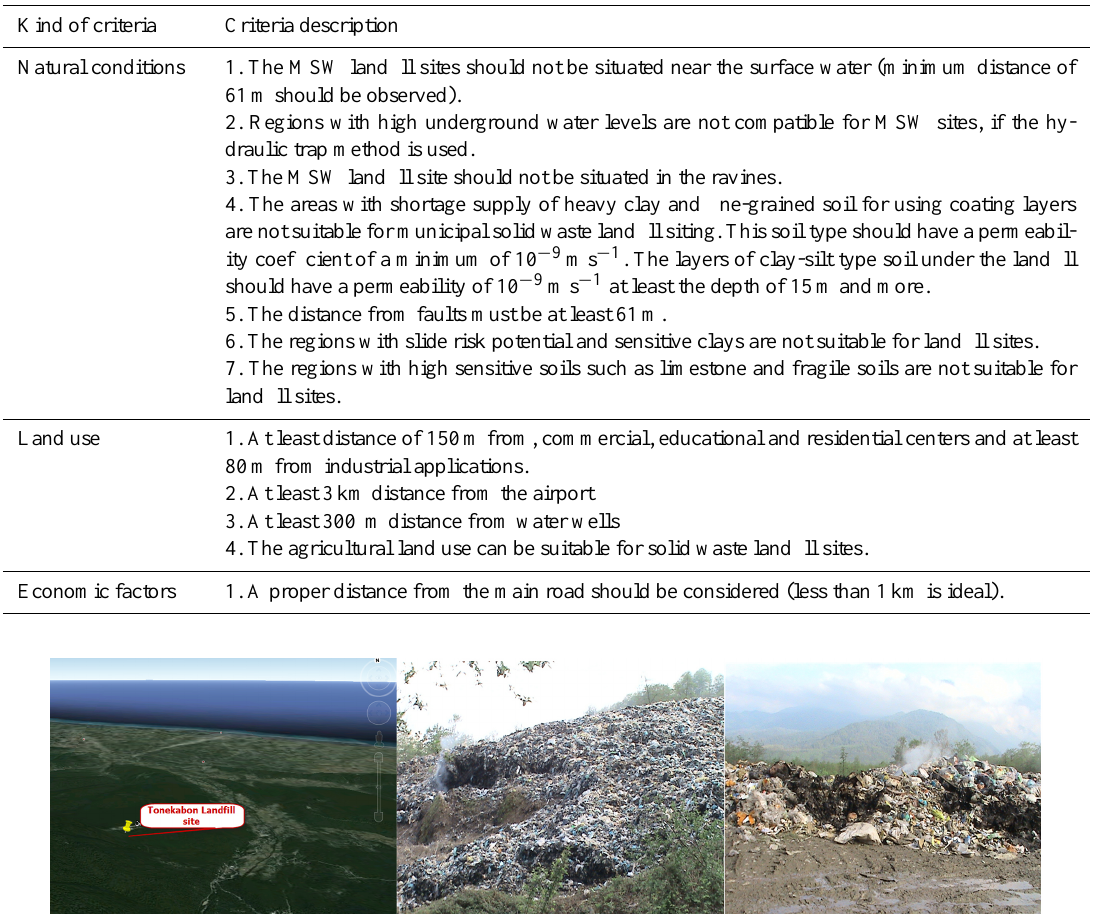
Table 2. Descriptions of the criteria used in the regional screening method.